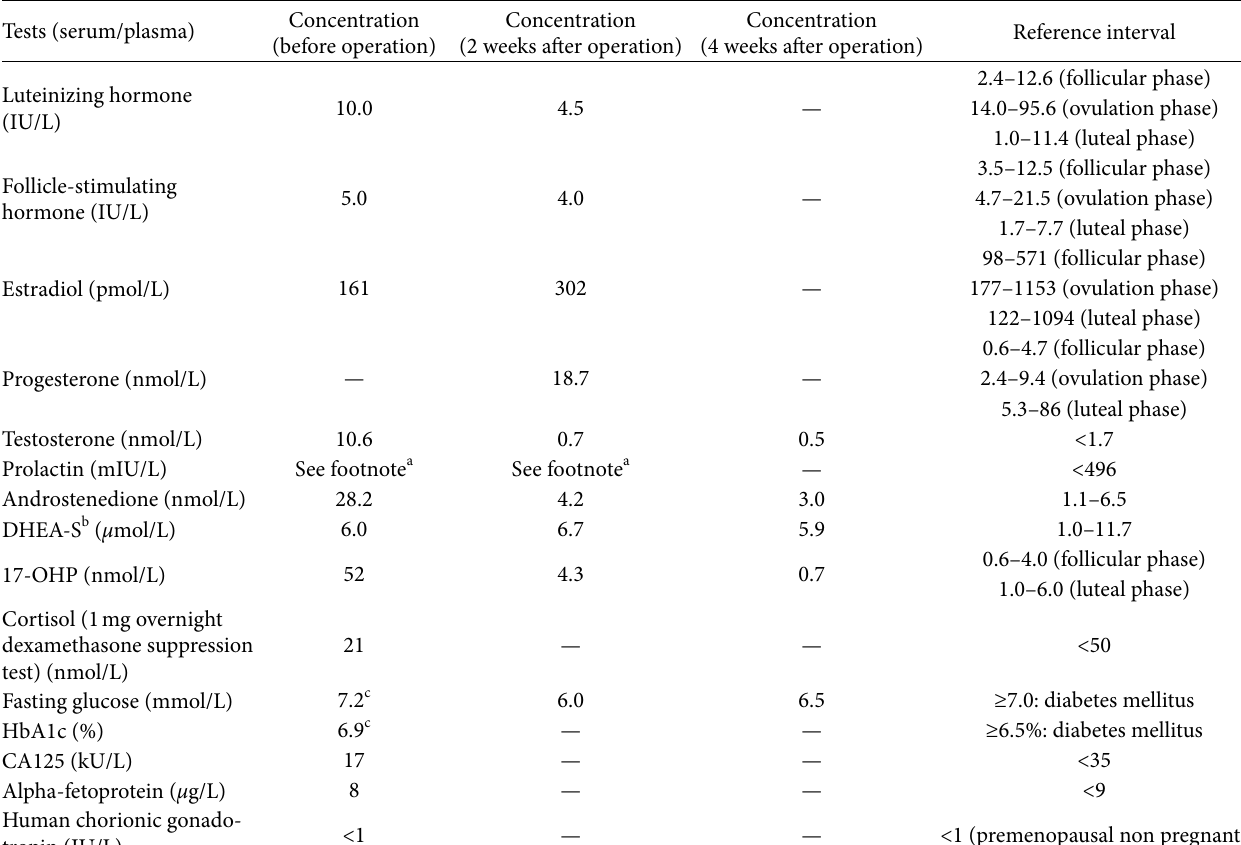
Table 1: Pre- and postoperative laboratory